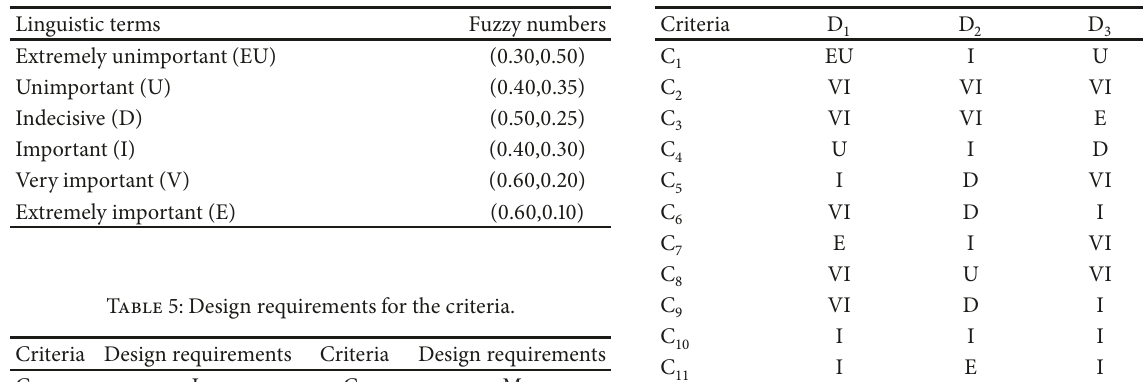
Table 4: Linguistic terms for the risks importance.